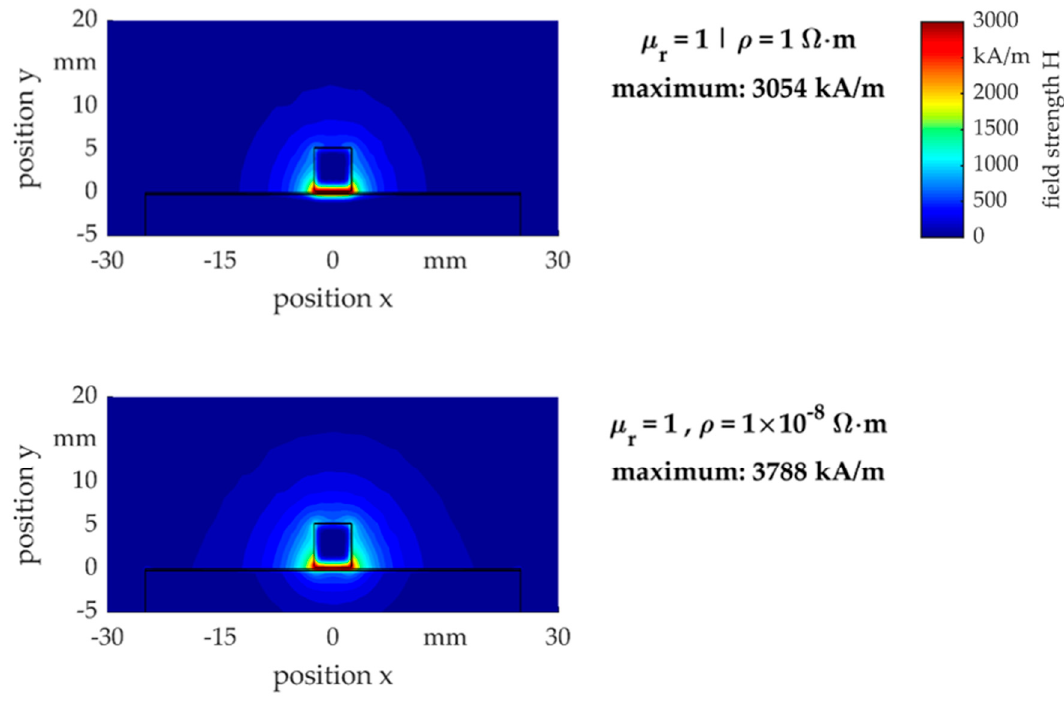
Figure 11. Distribution of the magnetic field with low relative permeability µ r of the die during the maximum current density in the tool coil.